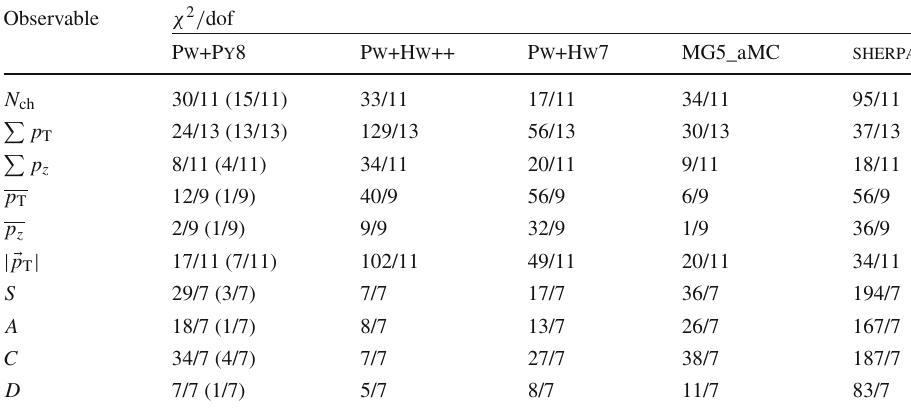
Table 3 Comparison between the measured distributions at particle level and the predictions of different generator setups. We list the results of the χ 2 tests together with dof. For the comparison no uncertainties in the predictions are taken into account, except for the Pw+Py8 setup for which the comparison including the theoretical uncertainties is quoted separately in